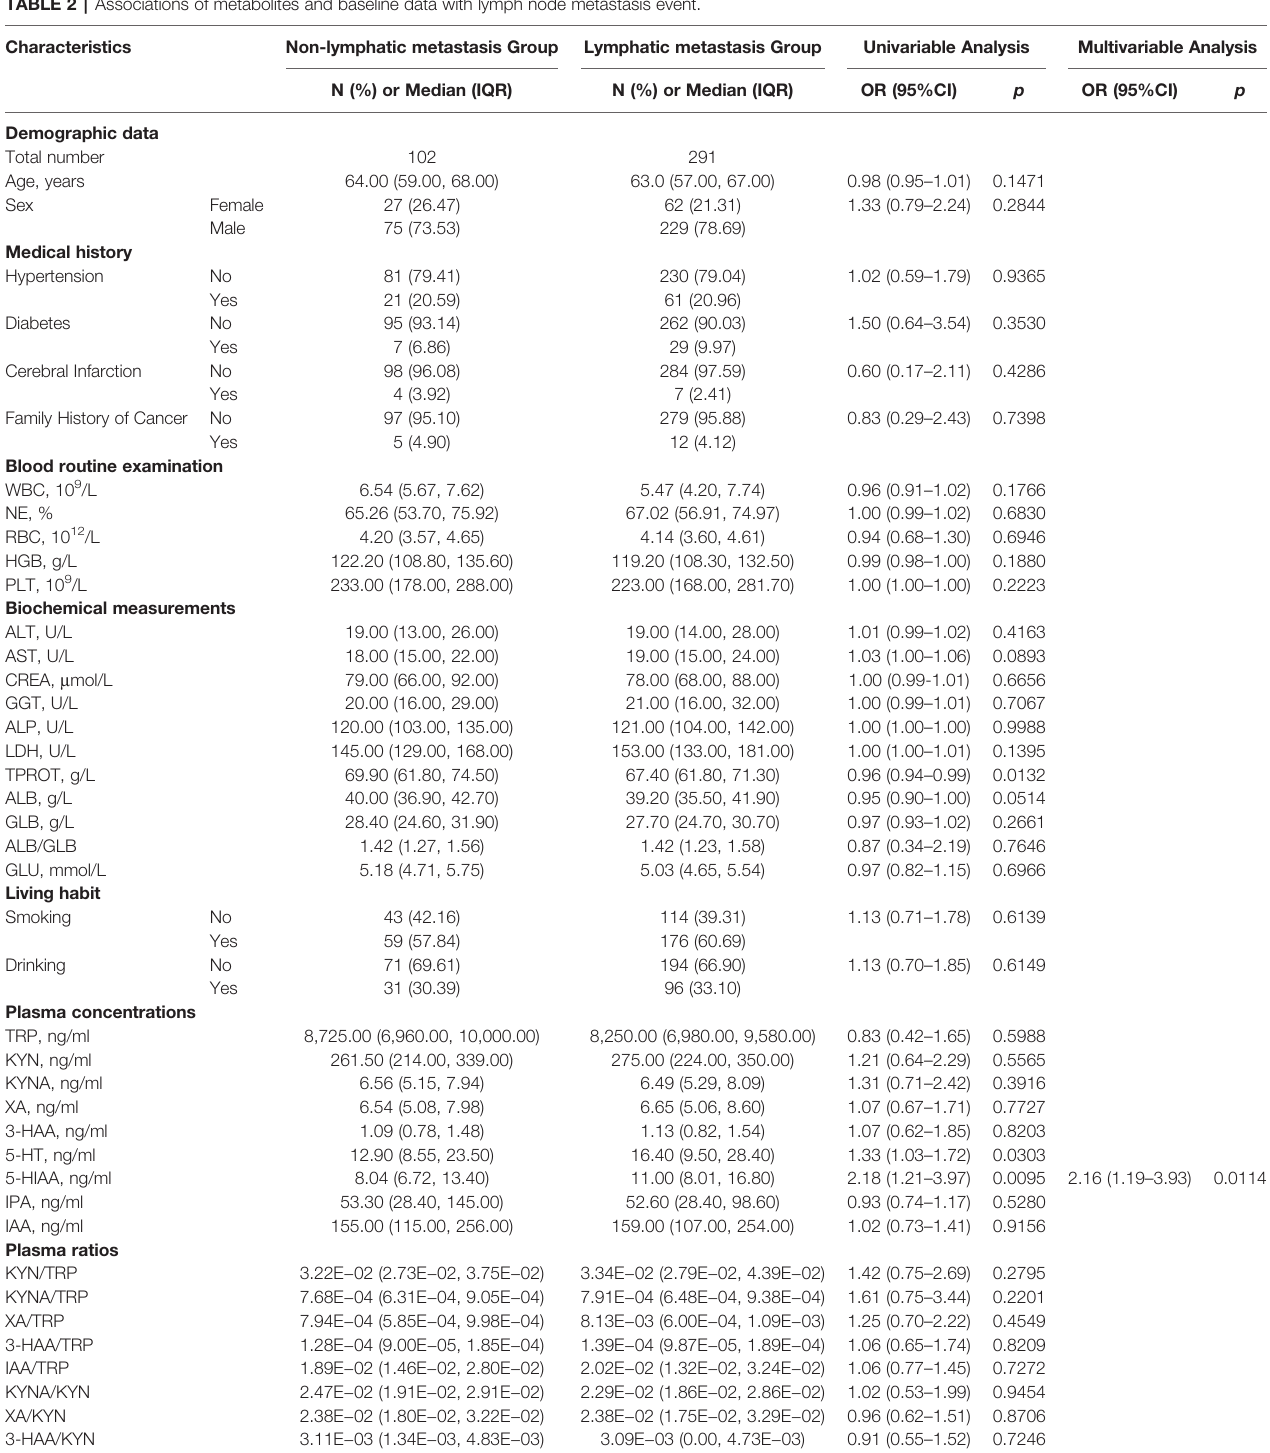
TABLE 2 | Associations of metabolites and baseline data with lymph node metastasis